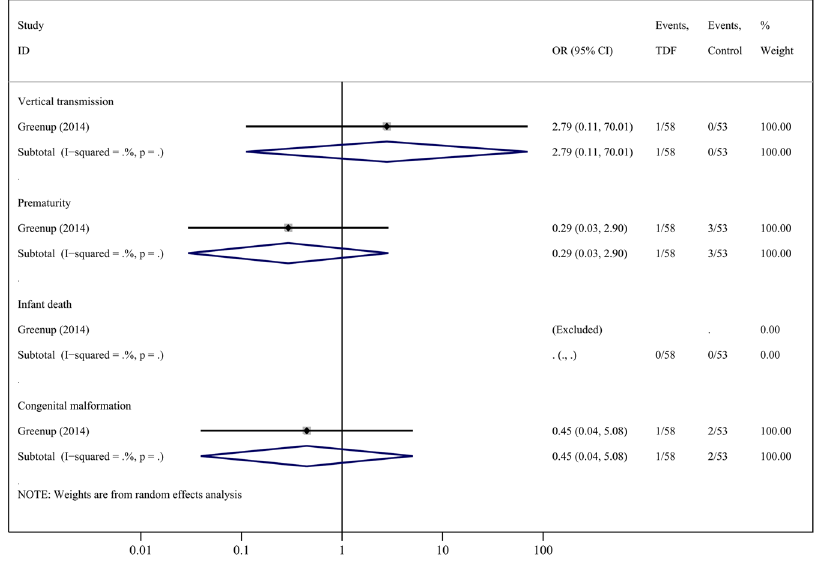
Figure 6. Forest plot showing meta-analysis of infant outcomes for studies comparing TDF versus LAM, based upon random-effects